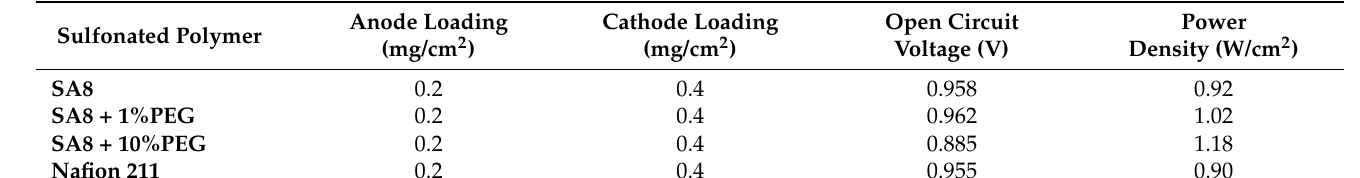
Figure 17. Fuel cell component performance diagram of SA8 blended with PEG. Table 5. Component measurement conditions and performance of SA8 blended with PEG.